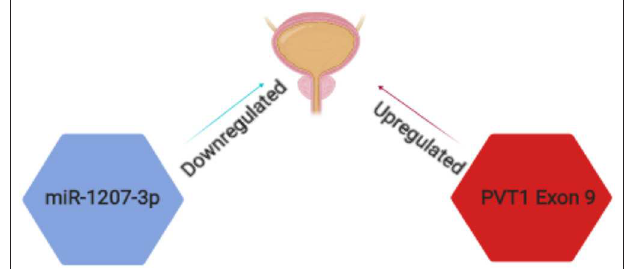
FIGURE 3 | Schematic representation of PVT1 transcripts implicated in prostate cancer. PVT1 exon 9 (red) is significantly overexpressed while miR-1207-3p (blue) is significantly under expressed in prostate cancer in men of African Ancestry.